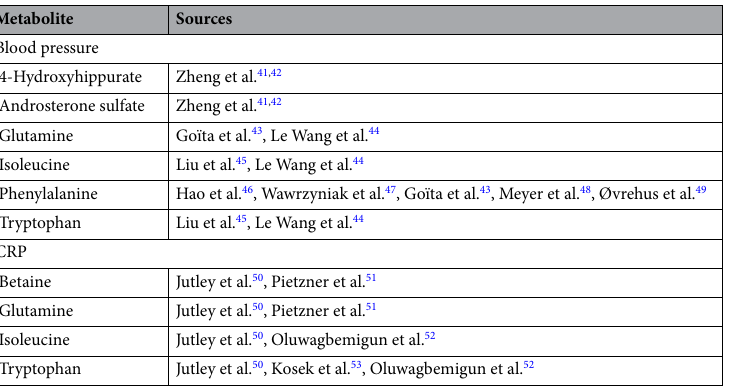
Table 1. Metabolites associated with conventional systemic markers of chronic disease risk in at least two independent observational studies. According to systematic search in PubMed. Metabolites without a match in our metabolites and those we did not replicated are available in Additional File